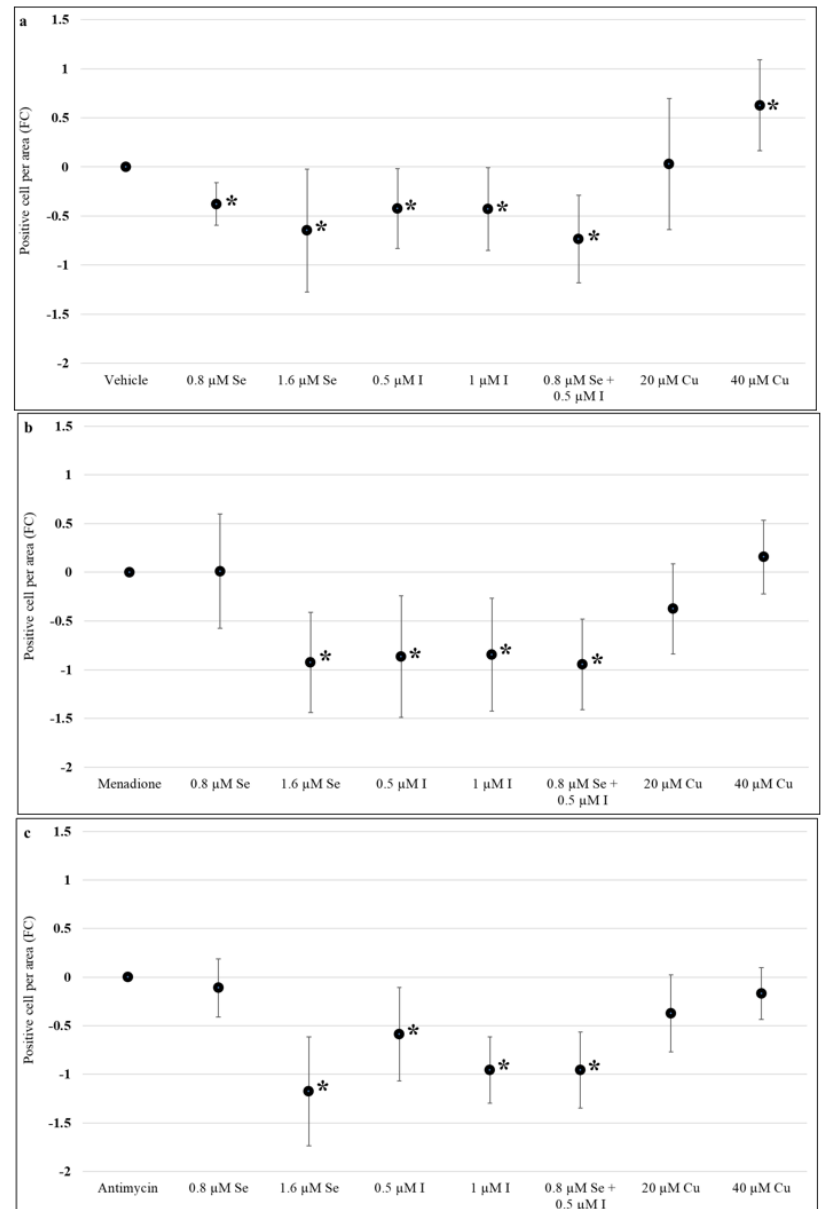
Figure 5. Effect of selenium, iodine, and copper supplementation on DNA damage in first trimester human placental explants. Placenta explants from 7 to 12 weeks of gestation ( n = 12) were cultured for 48 hours for syncytial regeneration followed by supplementation with sodium selenite (0.8 or 1.6 µM), potassium iodide (0.5 or 1 µM), combination of sodium selenite and potassium iodide (0.8 µM sodium selenite and 0.5 µM potassium iodide), or copper (II) sulfate (20 or 40 µM) for 72 hours with supplementation replenished every 24 hours. ( a ) Placental explants were harvested following 72 hours of supplementation and DNA damage assessed by immunolabelling for 8-hydroxy-2 ′ -deoxyguanosine. After 72 hours of supplementation, placental explants were treated with ( b ) 120 µM menadione or ( c ) 480 µM antimycin for 24 hours to induce oxidative stress and then assessed for DNA damage. Eight randomly selected regions per explant were used for quantification and statistical analyses. Data presented as a fold change (FC) relative to control ± standard error. Statistical significance was assessed using Generalised Estimating Equations (GEE) with independence correlation structure with log 2-transformed positive stain per area to estimate fold change compared to controls followed by pre-specified post-hoc Bonferroni adjusted comparisons. * Indicates statistically different ( p < 0.05) from